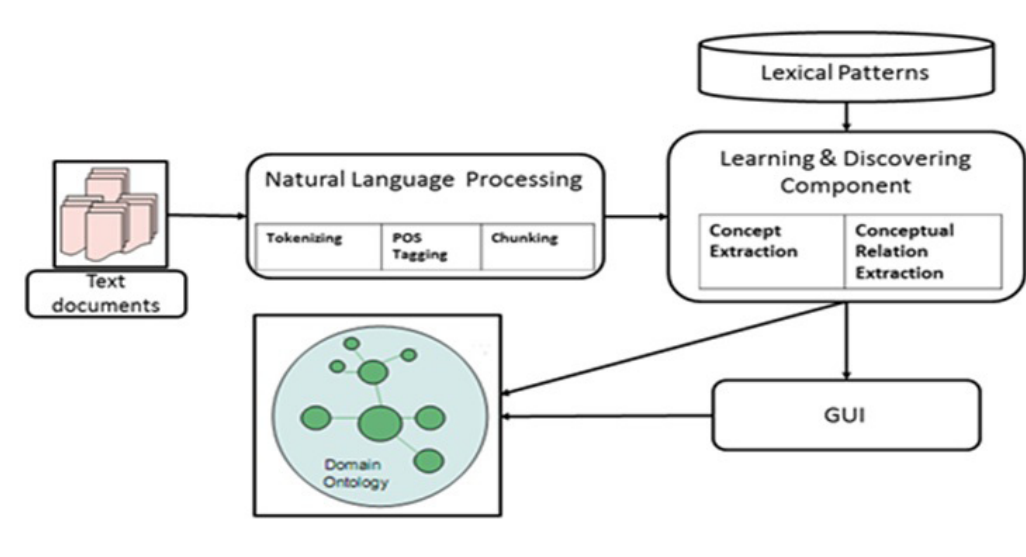
Figure 1. System